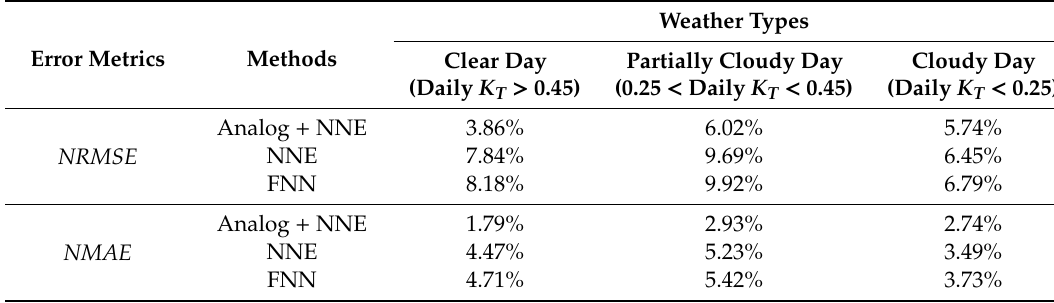
Table 2. Forecast performances of the methods under di ff erent weather